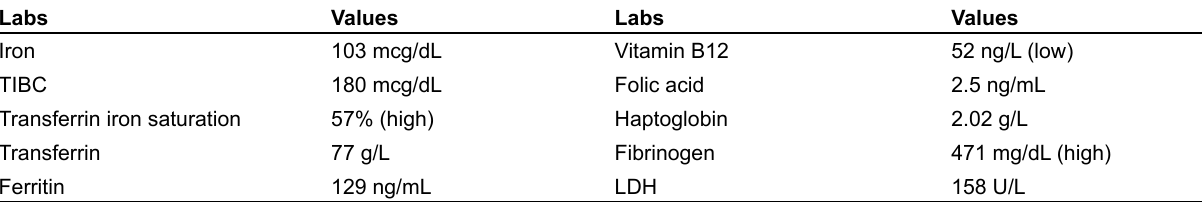
Table 2. Anemia workup